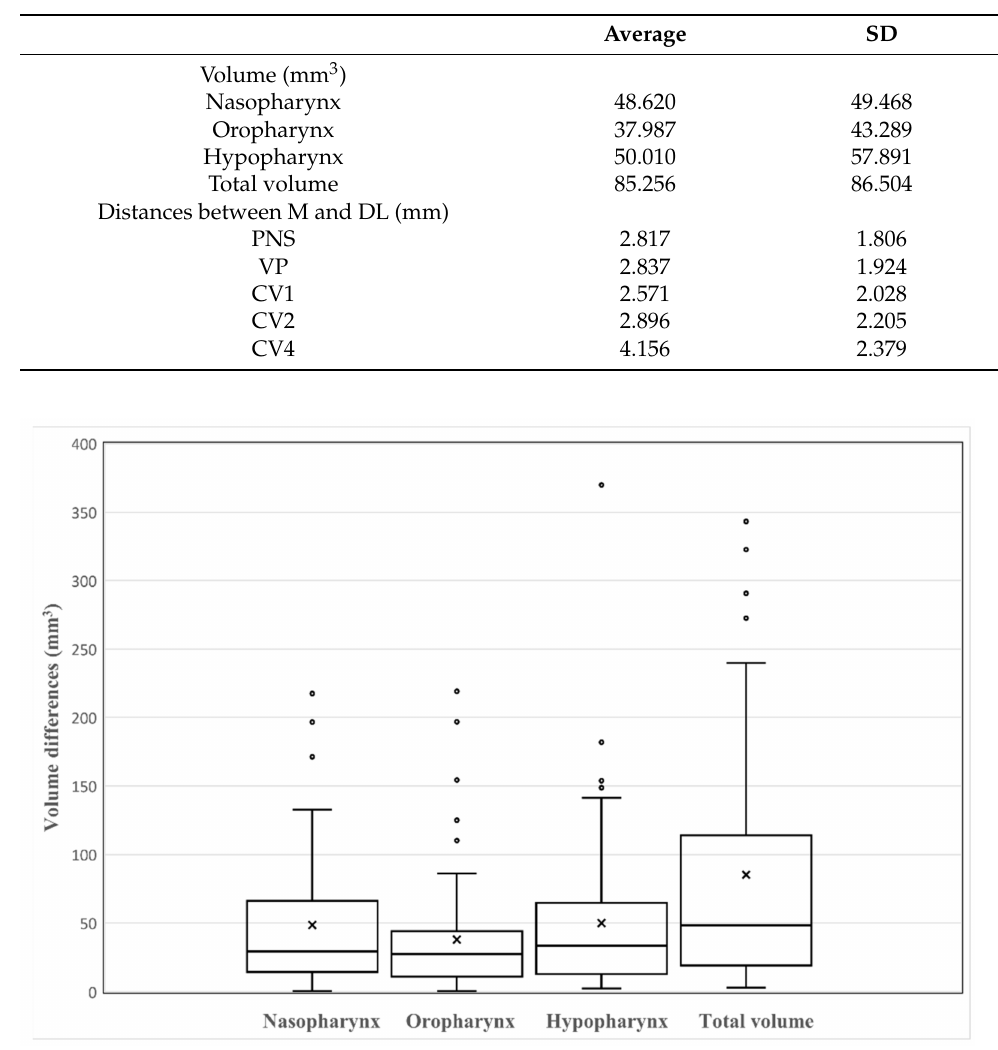
Figure 4. Boxplots of the differences between manual analysis and deep learning analysis (N = 61). In the boxplots, ‘x’ within the box marks the mean of volume